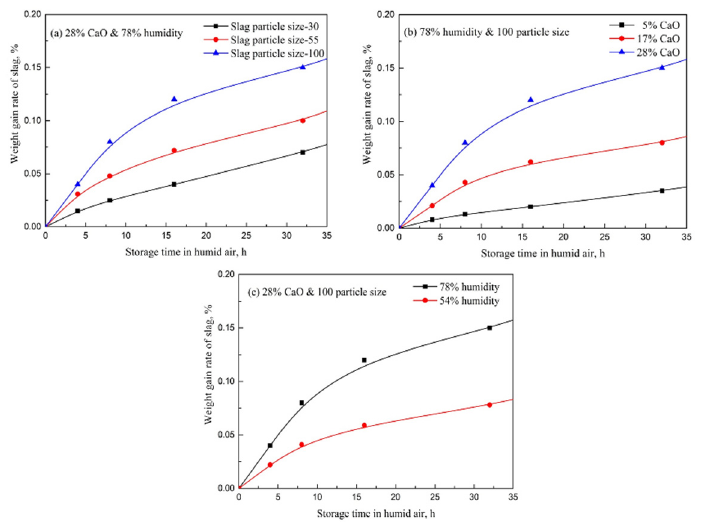
Figure 6. The change of slag weight gain rate with storage time in humid air is predicted by the SVR model under the conditions of ( a ) different slag particle size, ( b ) different CaO content, and ( c ) different air humidity.